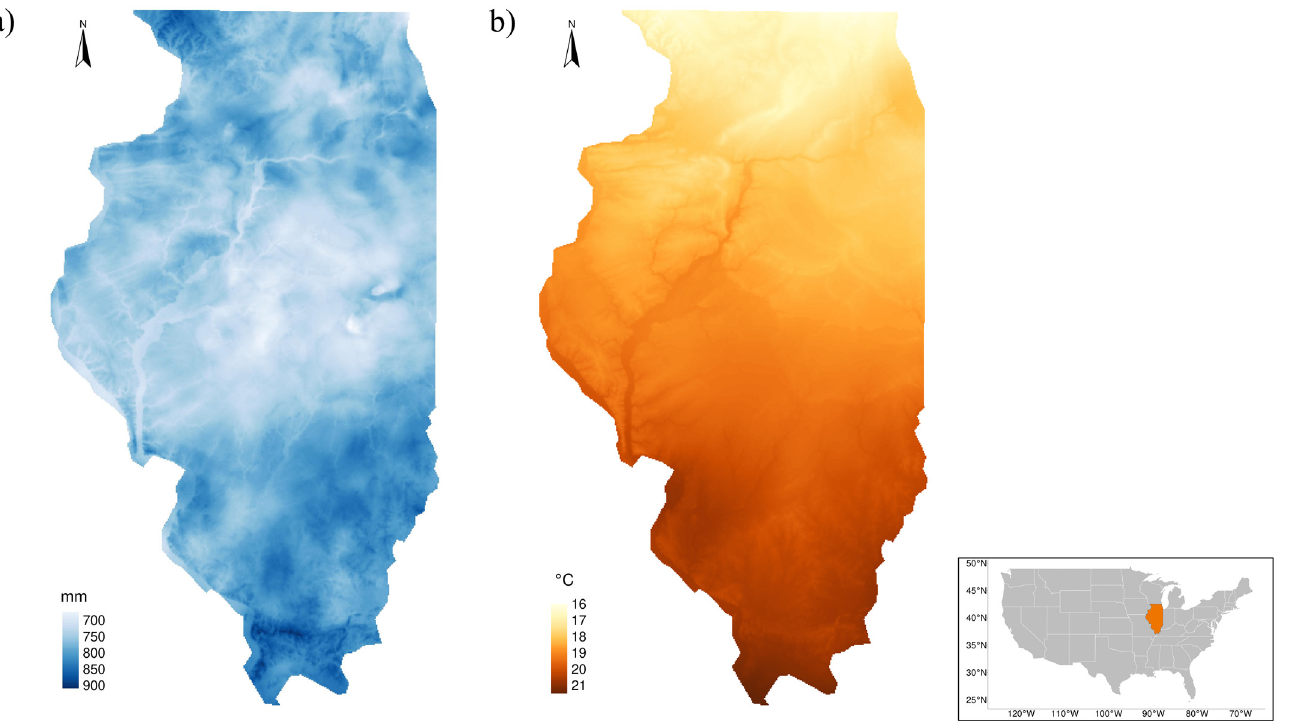
Figure 1. Average cumulative seasonal precipitation ( a ), and daily temperature ( b ), during the growing season (April–October) from 2005 to 2020. growing season (April–October) from 2005 to